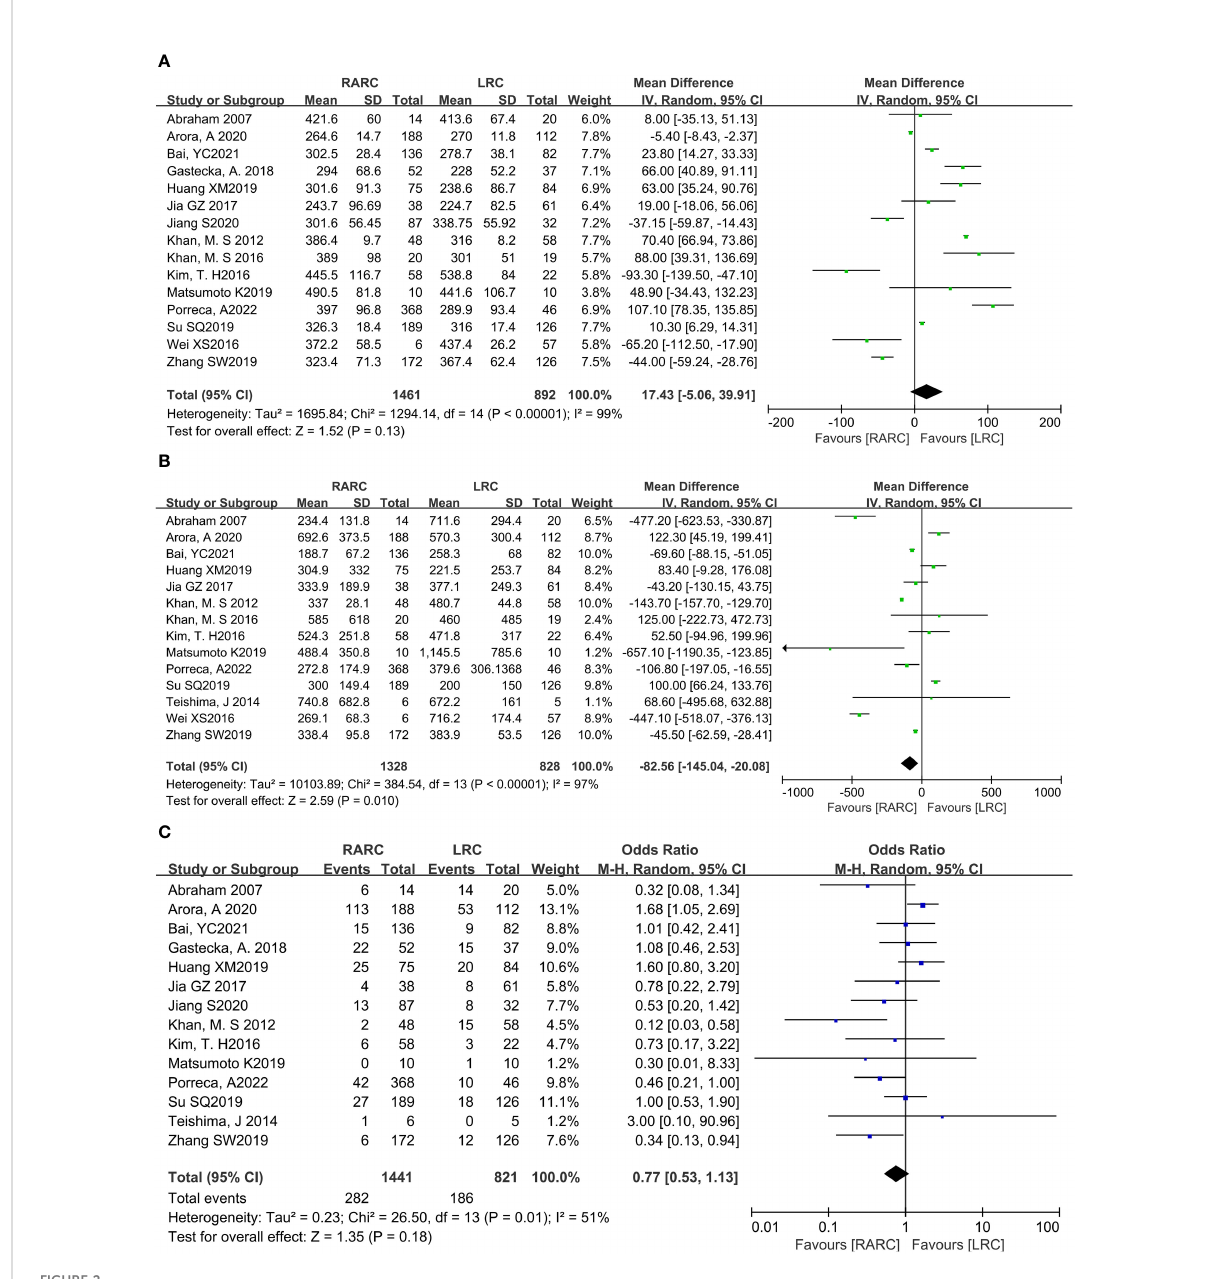
FIGURE 2 Forest plot of RARC versus LRC on (A) Total operative time, (B) Amount of blood loss, and (C) Transfusion